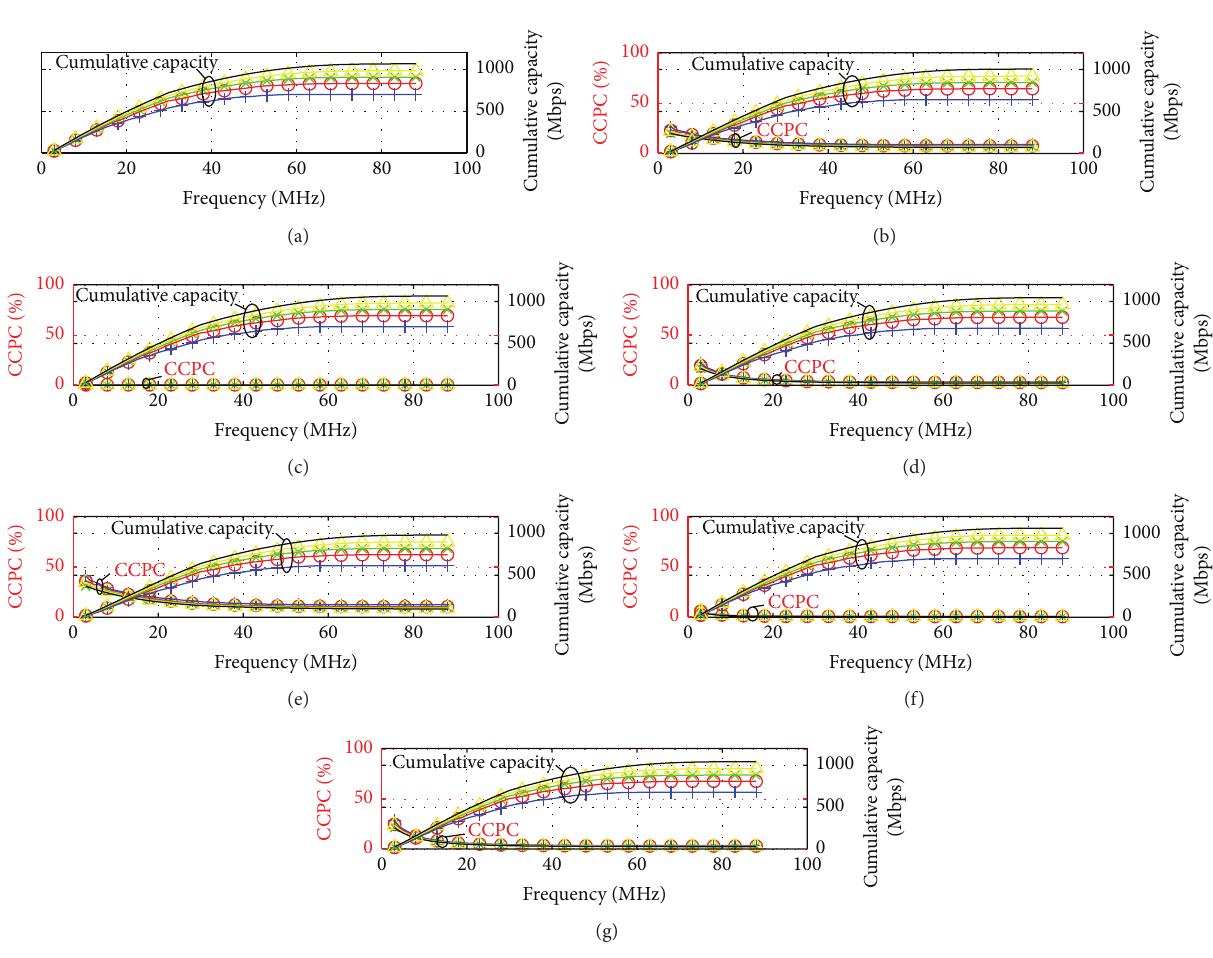
Figure 6: The same as in Figure 5, but for UN MV BPL